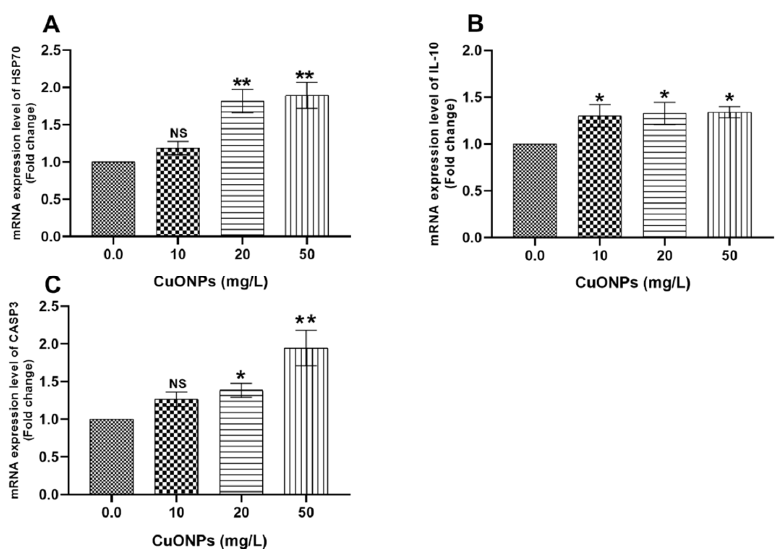
Figure 5. mRNA transcription profile of HSP70 ( A ), IL-10 ( B ), and CASP3 ( C ) genes in the hepatic tissues of Nile tilapia juveniles after exposure to sub-lethal concentrations of CuONPs (0.0 mg/L, 10 mg/L, 20 mg/L and 50 mg/L) for 25 days. The values are expressed as mean ± SEM ( n = 9). Asterisk (*) ( p < 0.05), and (**) ( p < 0.01) indicate significant differences between the exposure groups compared with the control group. NS indicates non-significant differences.